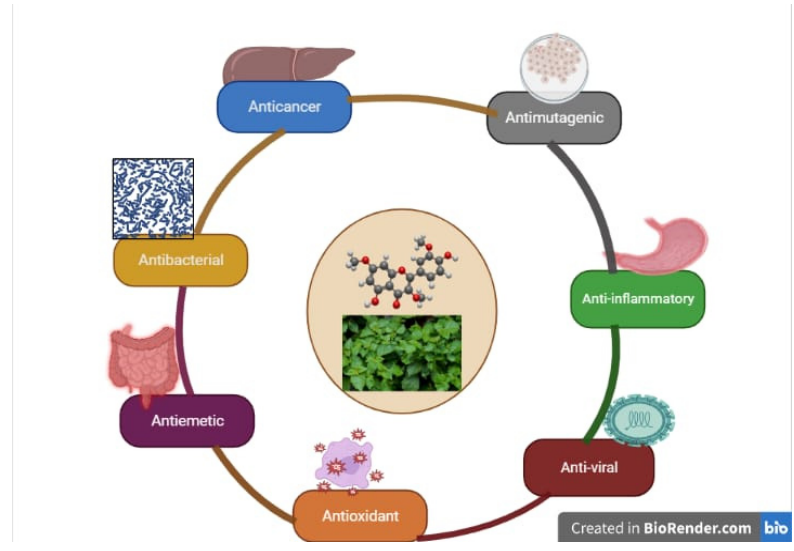
Figure 1. Biological activities of pachypodol. Table 1. Various pharmacological activities of pachypodol determined using different assays.